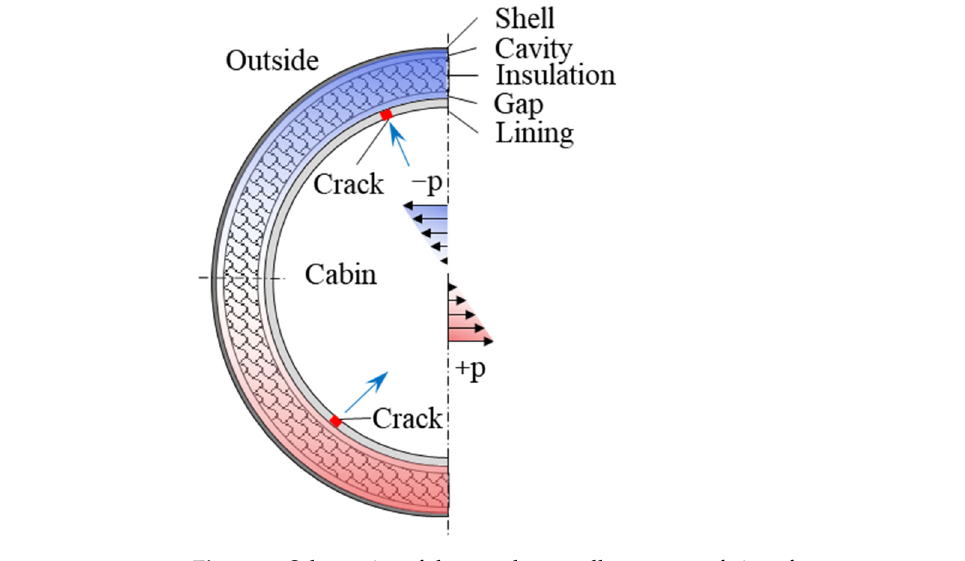
Figure 1. Schematics of the envelope wall structure of aircraft.